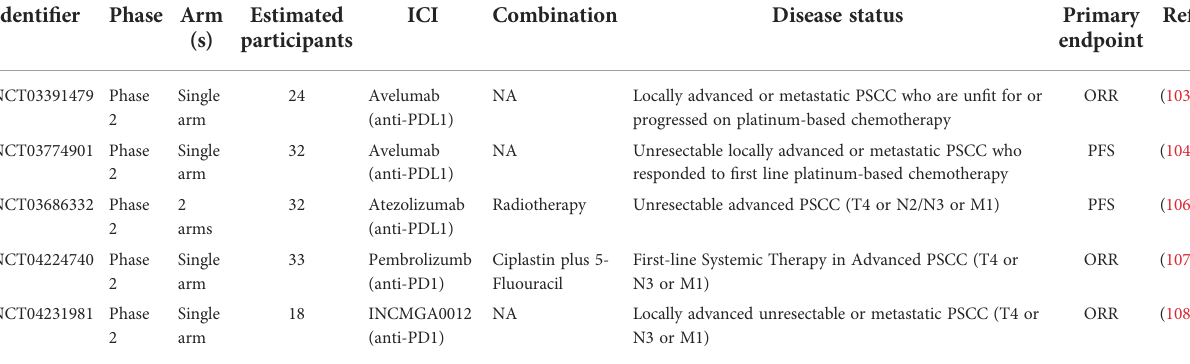
TABLE 1 Ongoing clinical trials of ICI in PSCC (basket trials not